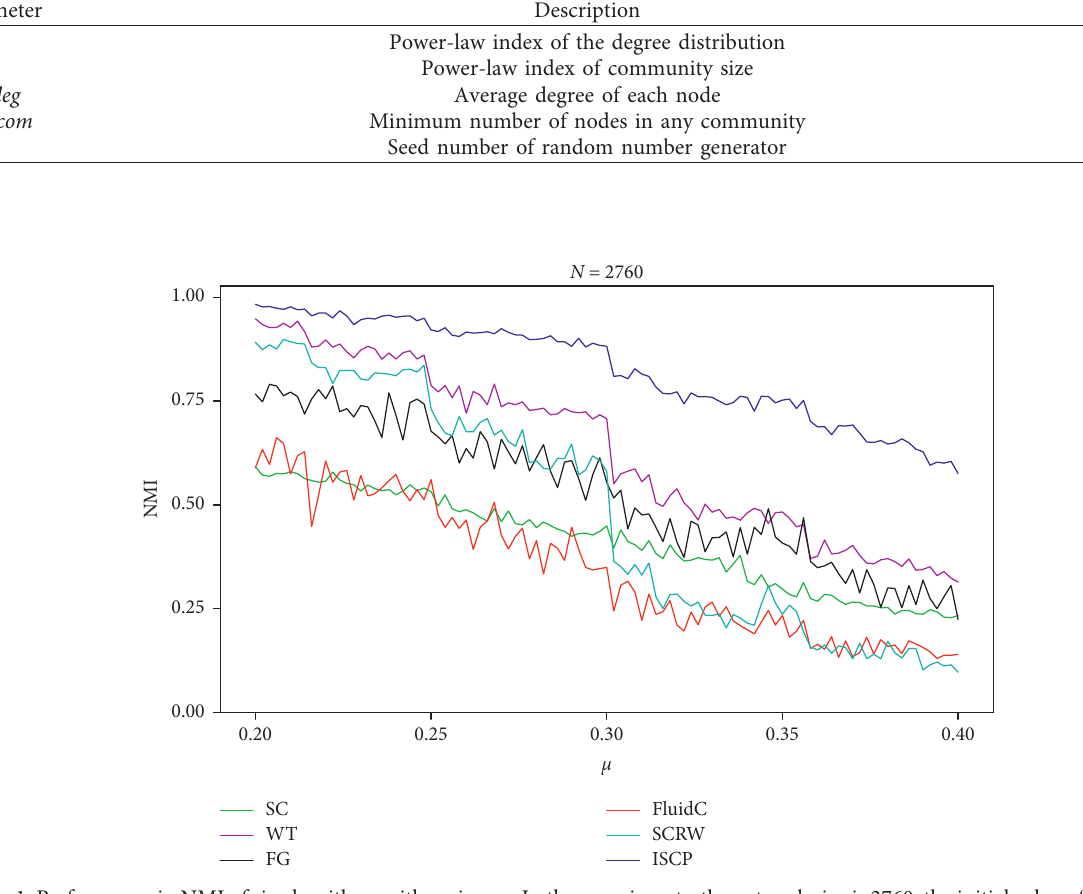
Figure 1: Performance in NMI of six algorithms with various μ . In the experiments, the network size is 2760, the initial value of μ is 0.2, the step length of μ is 0.002, and the number of iterations is 101.